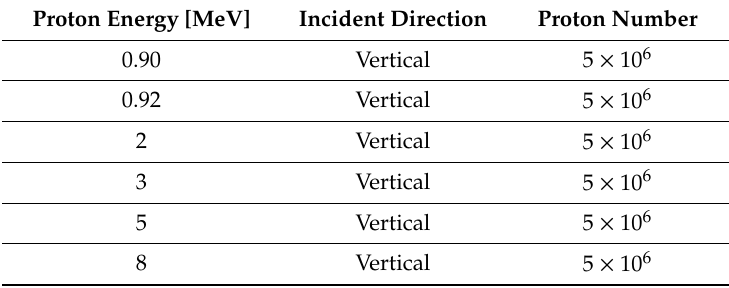
Figure 3. ( a ) The top view of the memory cell model established in Geant4; ( b ) The front view of the Geant4 model. Table 2. Simulation Setup.